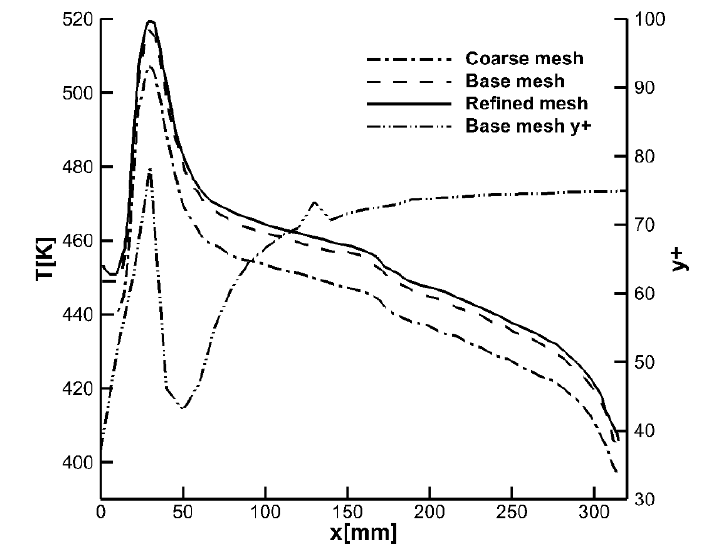
Figure 4. Wall temperatures for various mesh resolutions and y + for base mesh.